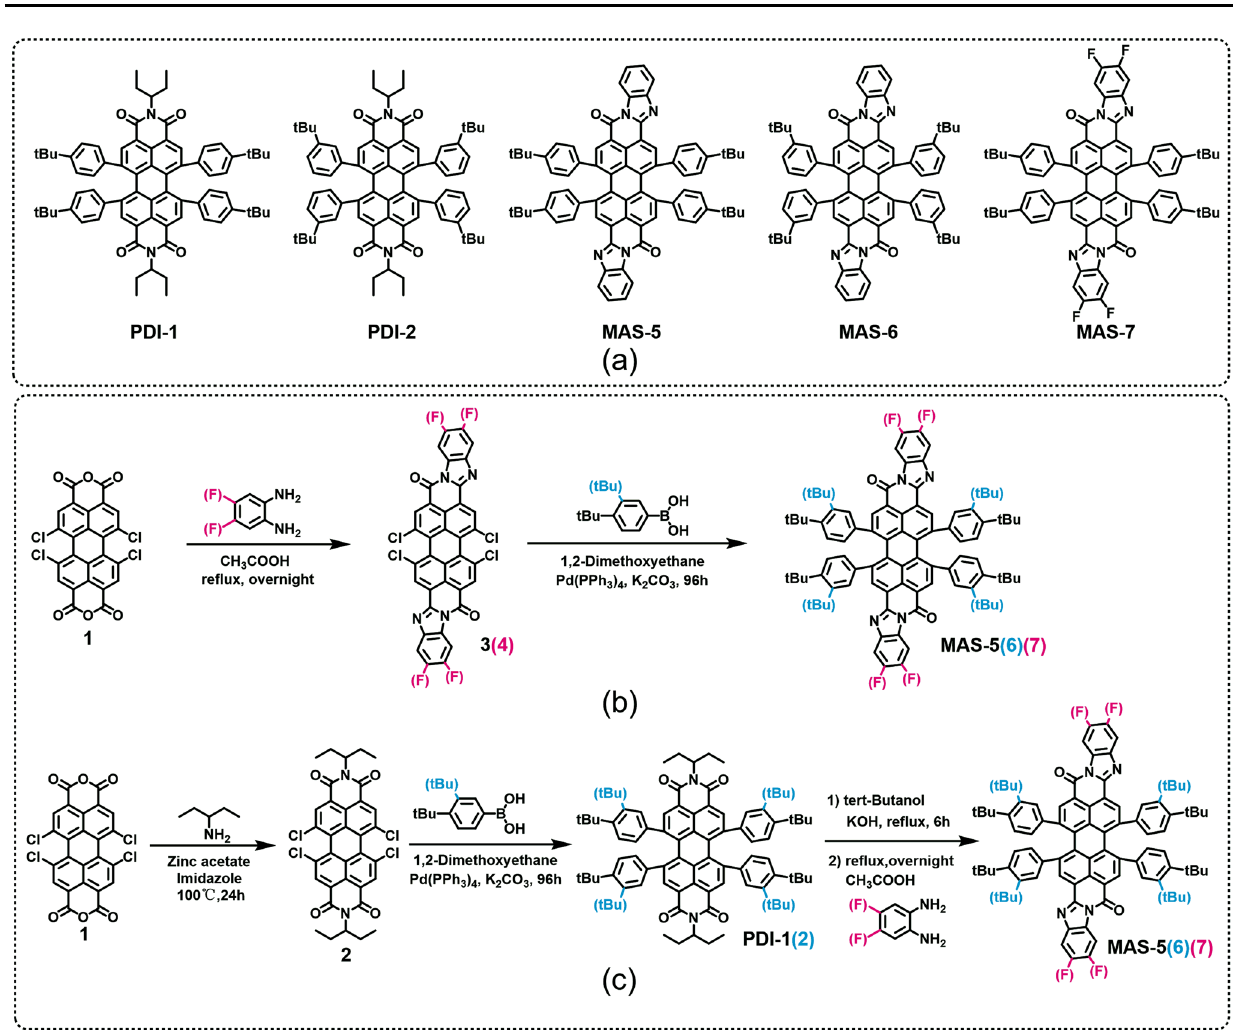
Fig. 1 a Molecular structures of PDI-1, PDI-2, MAS-5, MAS-6 and MAS-7. The synthetic route I ( b ) and II ( c ) of MAS-5, MAS-6 and